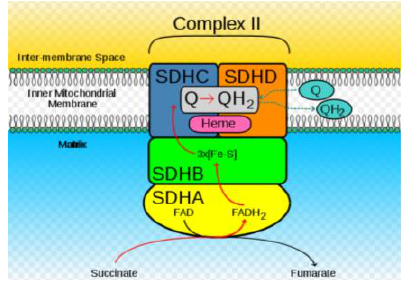
Figure 2 Figure 1: SDHA and SDHB as catalytic subunits, which protrude into the mitochondrial matrix and are anchored to the inner membrane by SDHC and